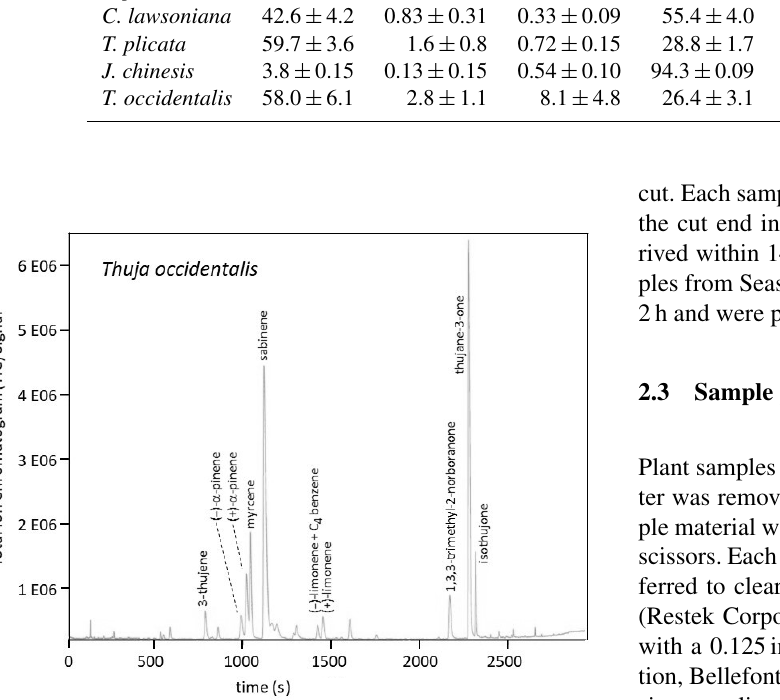
Figure 1. Total ion chromatogram (TIC) by GC-MS (gas chromatography–mass spectrometry) using a Supelco Beta DEX™ 120 chiral capillary column (0.25µm film thickness, 0.25mm i.d., and 30m long; Supelco Inc., Bellefonte, PA) for a T. occidentalis sample. The peak marked for ( − )-limonene contains a contribution from an unidentified C 4 -benzene. The two α -pinene enantiomers and the two limonene enantiomers were quantitated using the ion m/z =